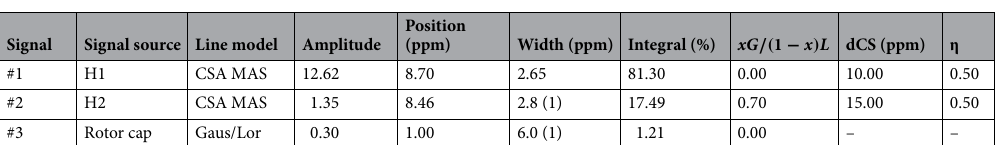
Table 3. 1 H MAS NMR chemical shift anisotropy data from spectra recorded at 10 kHz. In spectra analysis, position, linewidth, and integrated area of central components were deduced with non-linear iterative techniques. The analysis of spinning sideband patterns enables a determination of the isotropic chemical shift (δiso), and the axiality (dCS) and asymmetry parameter (η) of the chemical shift anisotropy tensor.